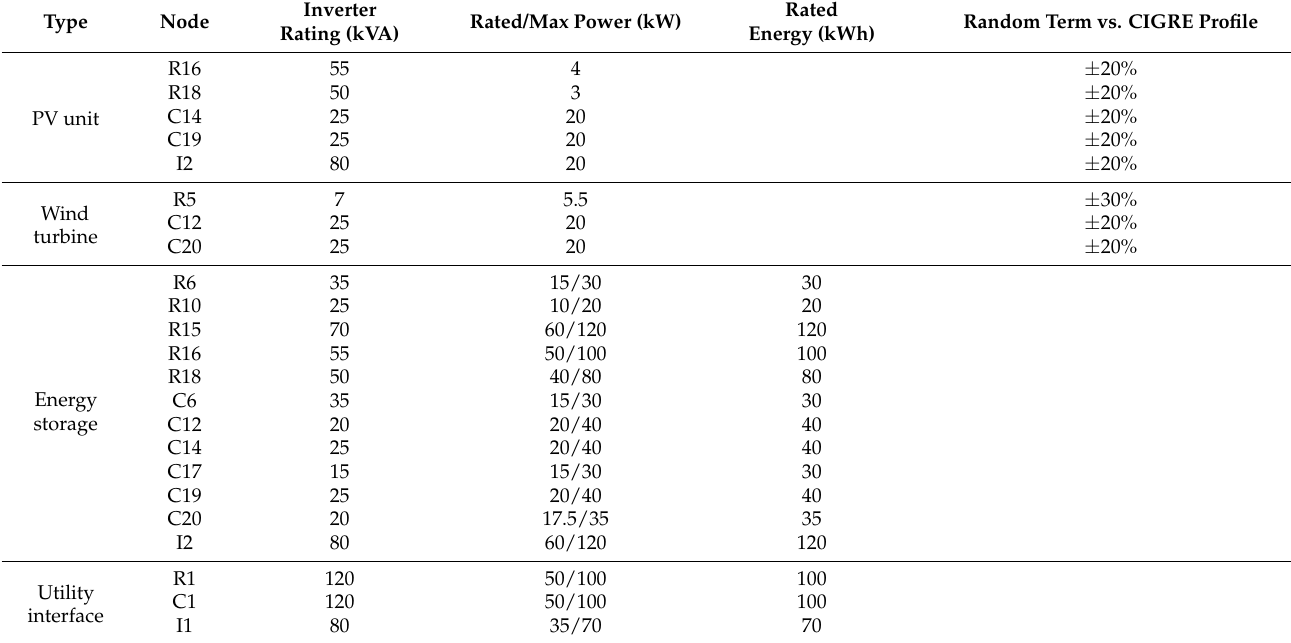
Table A3. Characteristics of the distributed energy resources considered in the application example in Figure